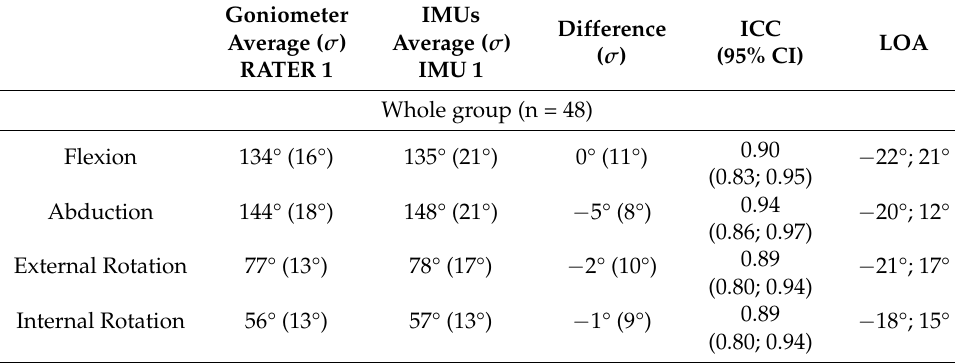
Table 7. Inter-instrument reliability indicators for goniometer and IMU measurements in CSCI patients and healthy group for RATER 1 and IMU